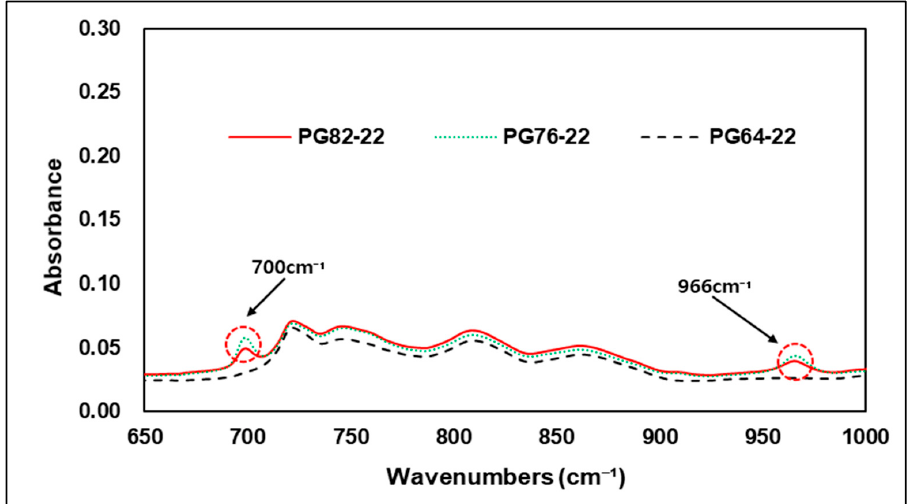
Figure 10. FTIR Spectrum of 650–1000 cm (cid:2879)(cid:2869) area .